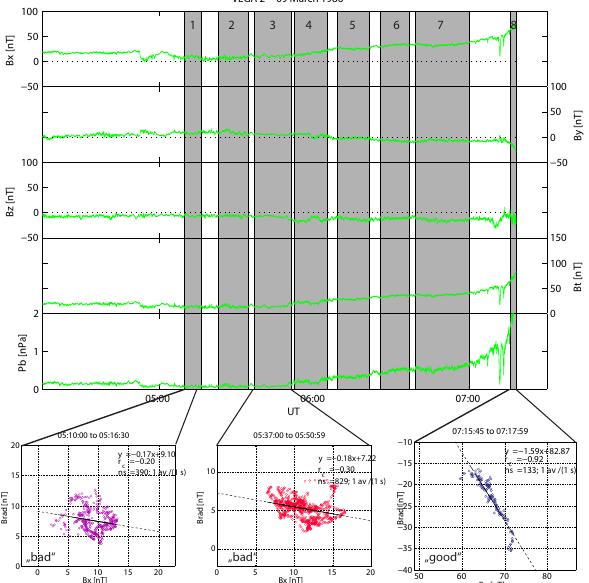
Fig.14. Toppanel: ThemagneticfielddatafromVEGA2withthesevenintervalsforwhichfieldlinedraping Figure 14. Top panel: the magnetic field data from VEGA 2 with wasstudiesmarkedingray. Bottompanels: Fieldlinedrapingfits,accordingtoEq.(3)forthreeintervals: two the seven intervals for which field line draping was studies marked “bad”fitwith | rc | ≤ 0 . 8 ;andtheonly“good”fitwith | rc | ≥ 0 . 8 . in gray. Bottom panels: field line draping fits, according to Eq. (3) for three intervals: two bad fits with | rc | ≤ 0 . 8; and the only good fit with | rc | ≥ 0 . 8.